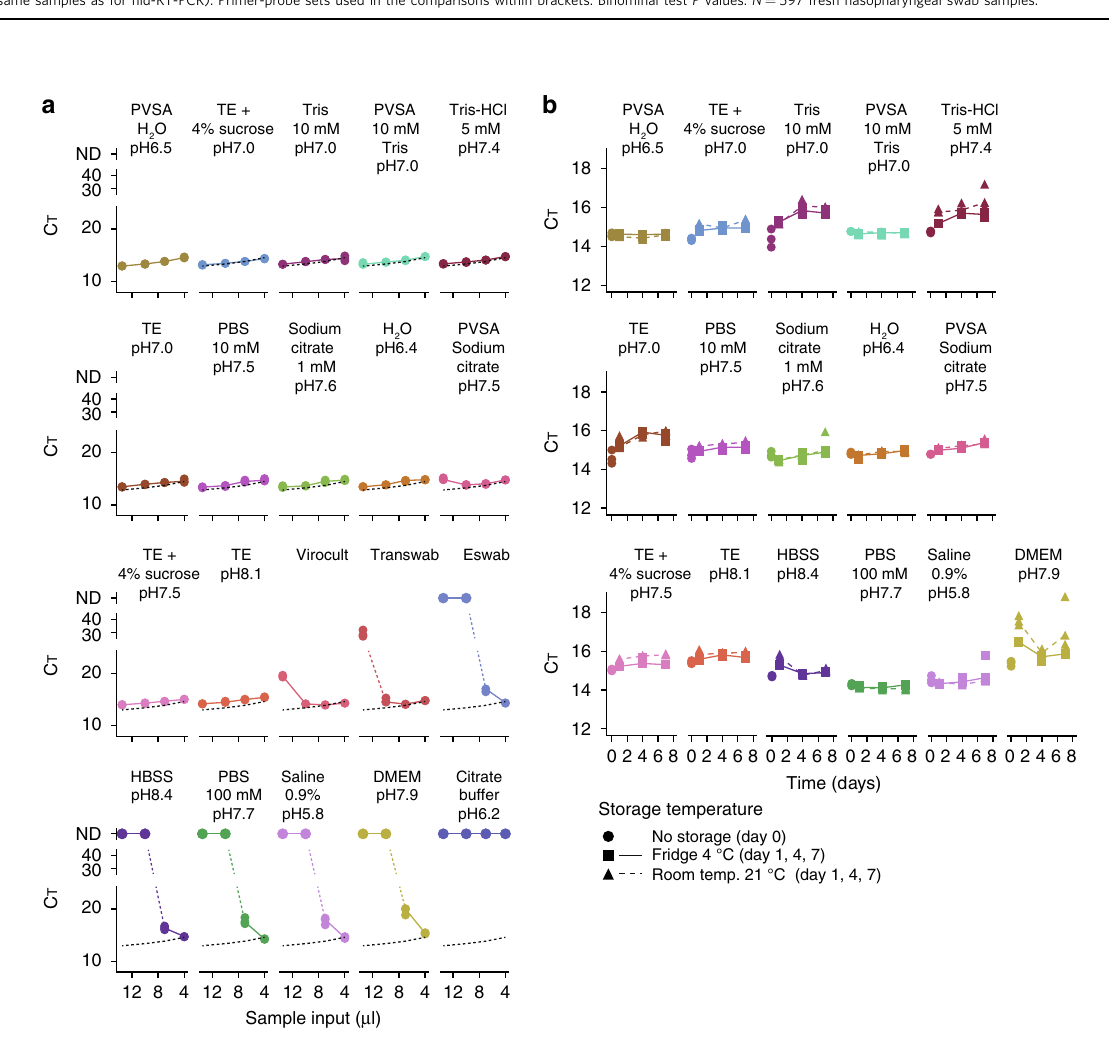
Fig. 6 Identi fi cation of generic transport buffers optimal for SARS-CoV-2 hid-RT-PCR. a Line charts of C T values ( y -axis) from hid-RT-PCR (N1 primer- probe pair) for different volume of input sample (13.5, 10, 7, or 4 μ l to a 20 μ l reaction; x -axis), showing the inhibition pro fi le of different transport buffers and media. The experiment was performed by adding equal amount of in vitro expanded SARS-CoV-2 to each buffer condition in experimental triplicates (dots). The dotted black lines indicate PVSA in H 2 O condition, included for comparison. The buffers are ordered according to minimal C T . b Line charts of C T values ( y -axis) from hid-RT-PCR (N1 primer-probe pair, 4 μ l input to 20 μ l reactions) of in vitro expanded SARS-CoV-2 stored in different buffers for up to 7 days ( x -axis) in fridge (4 °C, square) or room temperature (21 °C, triangle) before subjecting the samples to heat inactivation (95 °C 30 min) and hid- RT-PCR. The data are shown as individual replicates (points, n = 3) and median